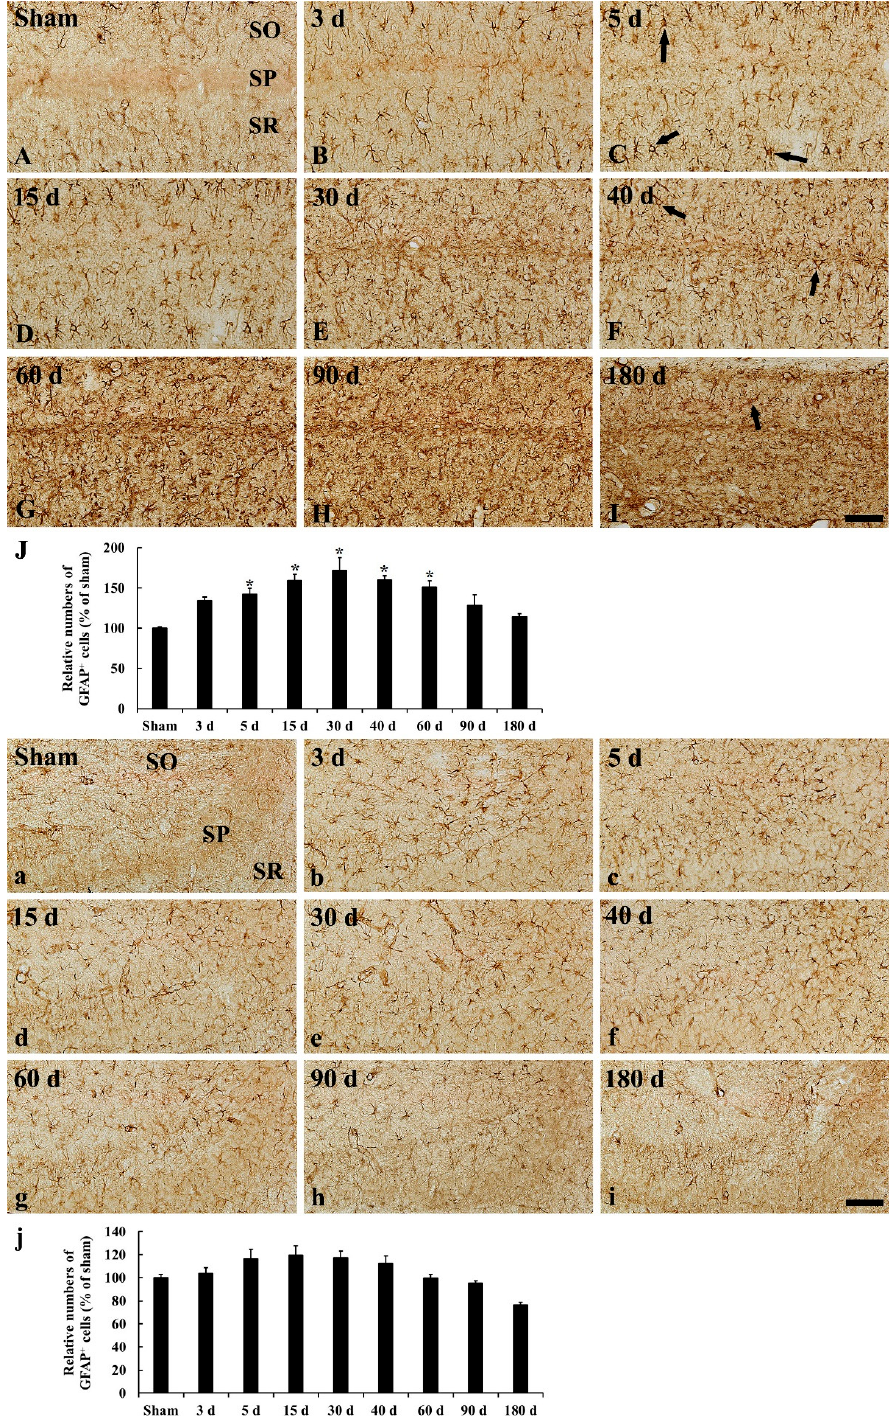
Figure 5. High magnification of GFAP immunohistochemistry in the CA1 ( A – I ) and CA2/3 ( a – i ) of the sham operated ( A , a ) and ischemia operated ( B – I , b – i ) groups after tgCI. In the sham operated group, GFAP immunoreactive astrocytes show typical resting form. In the ischemia operated group, GFAP immunoreactive astrocytes in the CA1 become larger in cell body and thicker in their processes until 40 days after tgCI. From 60 days after tgCI, GFAP immunoreactive astrocytes are broken in morphology, and the broken morphology is severest at 180 days after tgCI. In the CA2/3, GFAP immunoreactive astrocytes are not significantly altered in morphology after tgCI. Scale bar = 50 µ m. ( J , j ) Relative numbers of GFAP immunoreactive astrocytes in the CA1 ( J ) and CA2/3 ( j ) ( n = 7; * p < 0.05 vs. sham operated group). The bars indicate the means ±